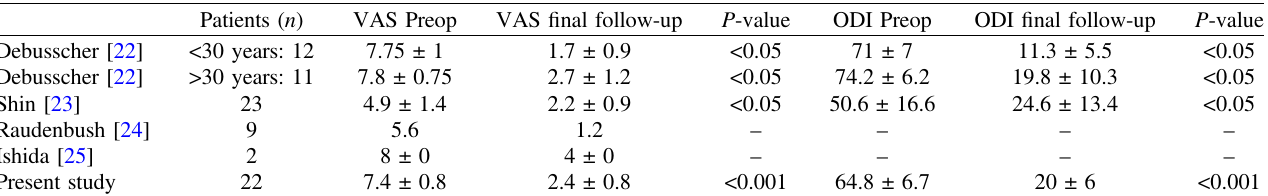
Table 2. Preoperative VAS for low back pain and ODI score before surgery and at fi nal follow-up in different studies performing pars repair by the